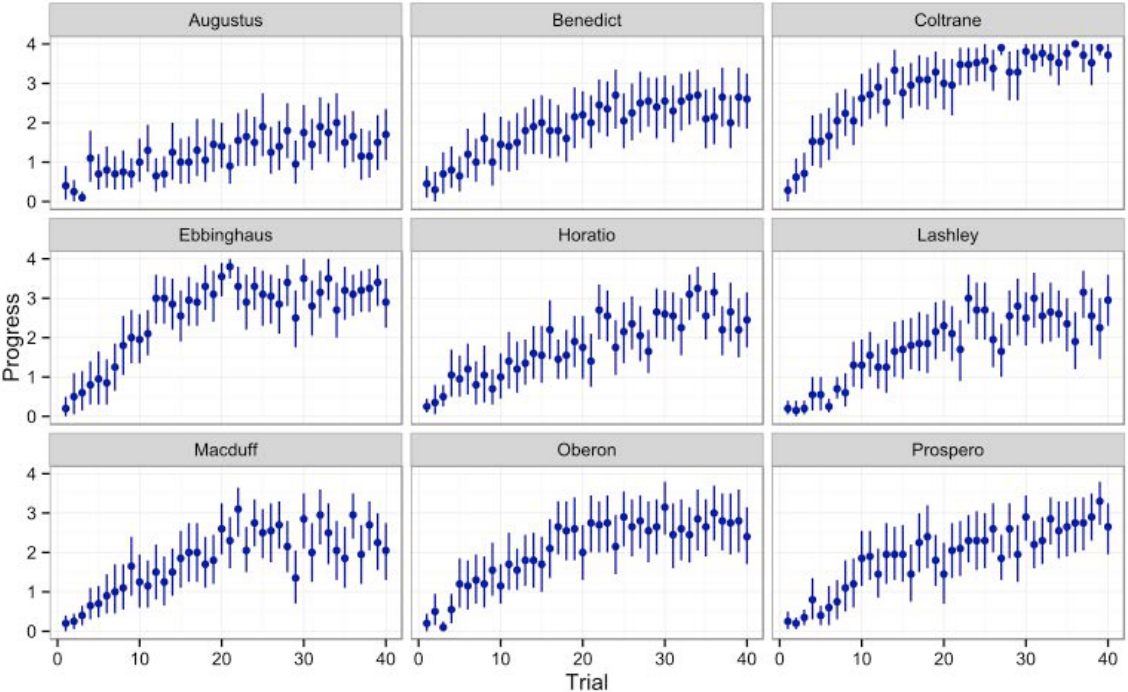
Figure 3. Average Progress data from 20 sessions of 40 trial SimChain, in 9 monkeys. Bars indicate standard errors.